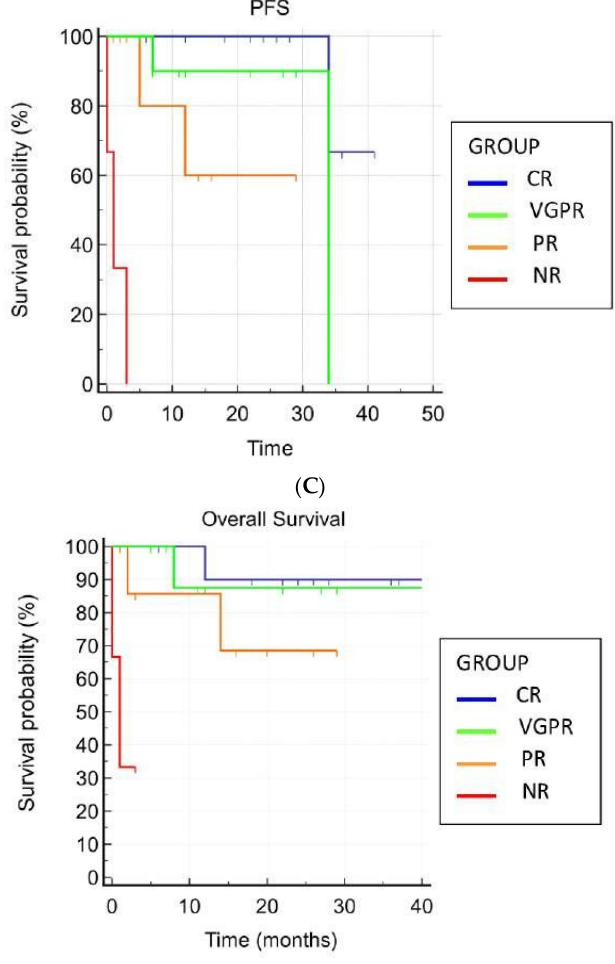
Figure 1. Overall and progression-free survivals. ( A ) Overall survival in all patients. ( B ) Progression-free survival in all patients. ( C ) Overall survival and hematological response. ( D ) Progression-free survival and hematological response.